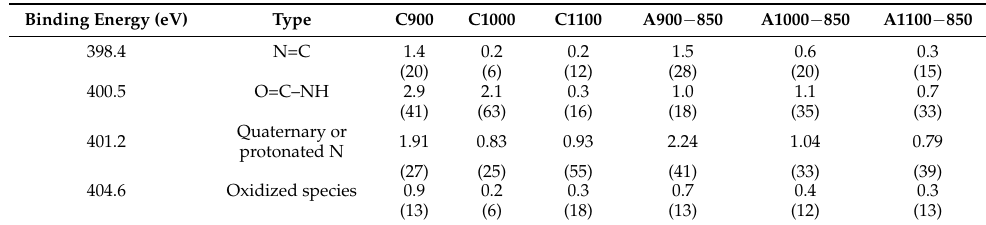
Figure 4. X-ray photoelectron spectroscopy (XPS) N 1 s spectra: ( a ) C900; ( b ) C1000; ( c ) C1100; ( d ) A900 − 850; ( e ) A1000 − 850; and ( f ) A1100 − 850. The values are given in an atomic ratio (%) of total intensity. Table 3. Results of the fits of the XPS N 1s region, values given in at.% (percent of total